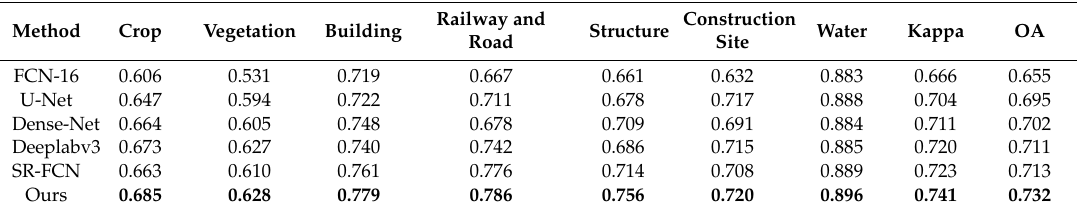
Table 1. The precision and overall accuracy of the FCN-16, U-Net, Dense-Net, Deeplab-v3, SR-FCN and our method on the 2017 patch